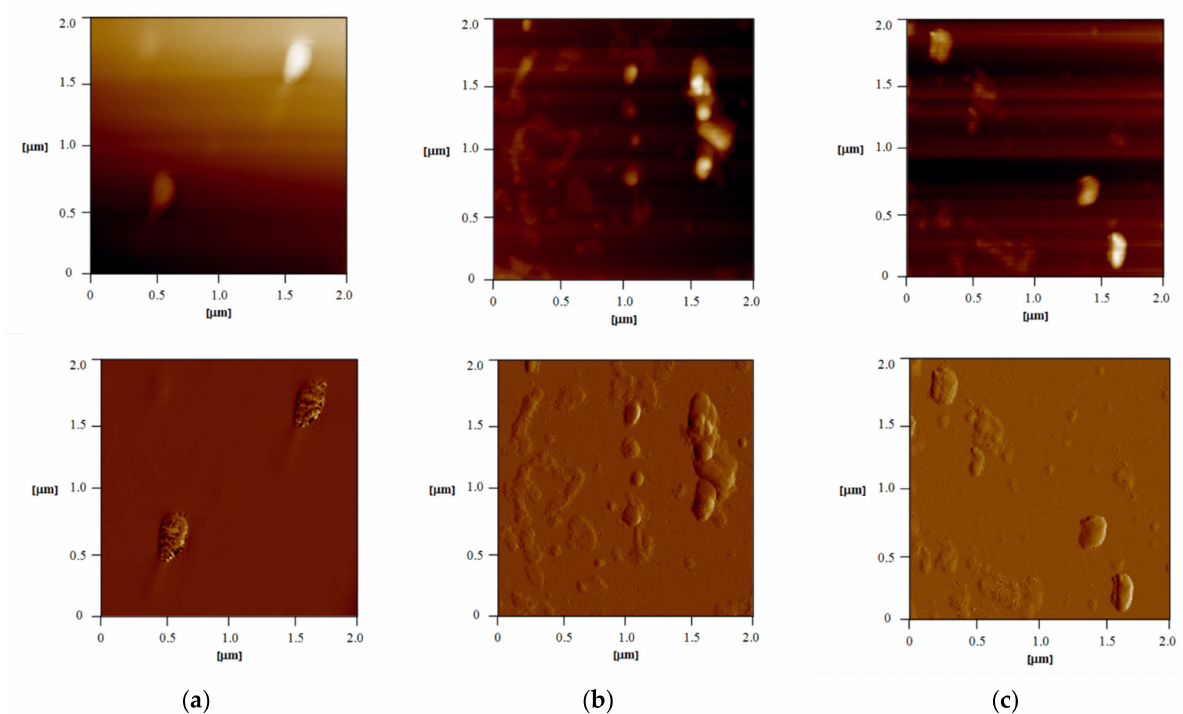
Figure 3. AFM images of samples F5 ( a ), F6 ( b ), and F8 ( c ): 2D topography of 2 × 2 µ m area of the sample (up) and error signal of 2 × 2 µ m area of the sample